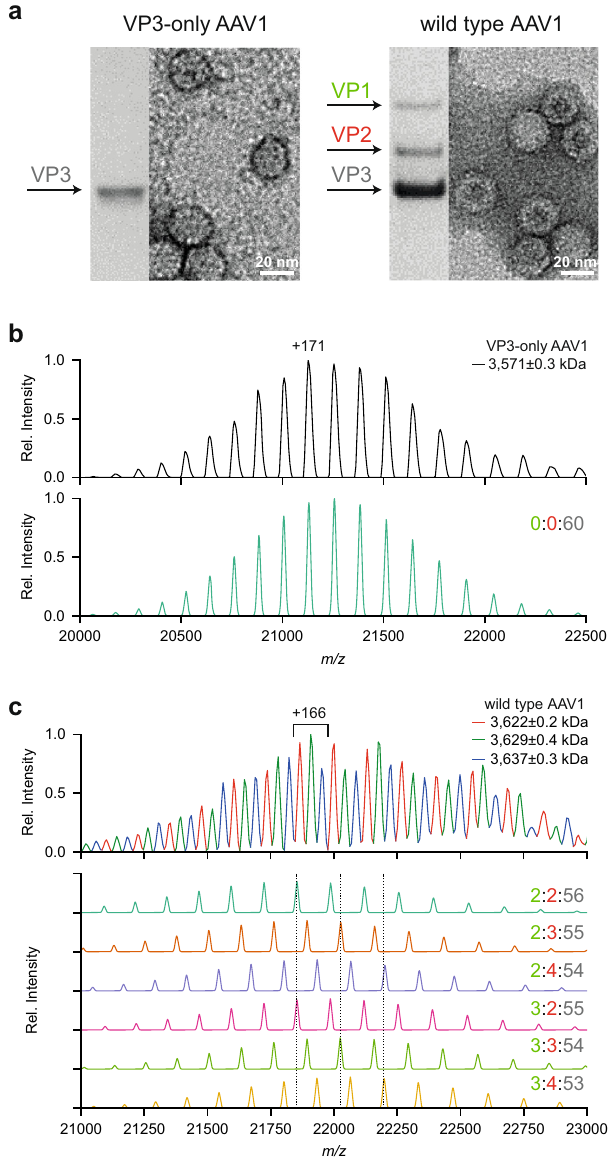
Fig. 2 Adeno-associated virus (AAV) capsid structure and heterogeneity. a Coomassie stained SDS-PAGE and negative stain EM images of VP3-only AAV1 (left) and wild-type AAV1 (right) capsids. b Native MS spectrum of the VP3-only AAV1 capsids, with an assigned mass of 3,571 ± 0.3 kDa (masses are reported as mean ± s.d.), is shown at the top. The simulated native spectrum for capsids with a 0:0:60 (#VP1:#VP2:#VP3) stoichiometry is shown below and accounts for all observed peaks in the experimental data. c Native MS spectrum of wild-type AAV1 capsids, showing three peak series with a relative mass shift of around 6.5 kDa. The simulation of several capsid stoichiometries are shown below and illustrate the potential coinciding charge state distributions caused by VP3-to-VP2 and VP3-to-VP1 substitutions. VP ratios are indicated for each simulation respectively